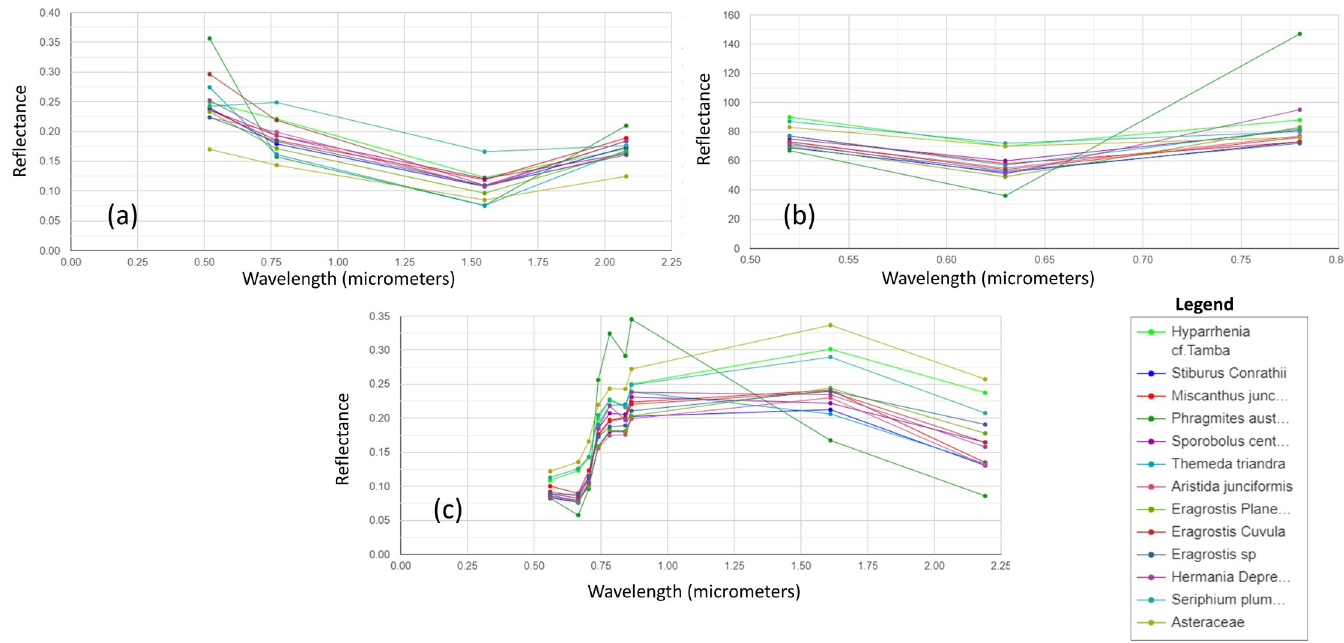
Fig 2. Species spectral reflectance curves of twelve grass species. (a) Extracted from Landsat 7 ETM+, (b) Extracted from ASTER MI, (c) Extracted from Sentinel-2.